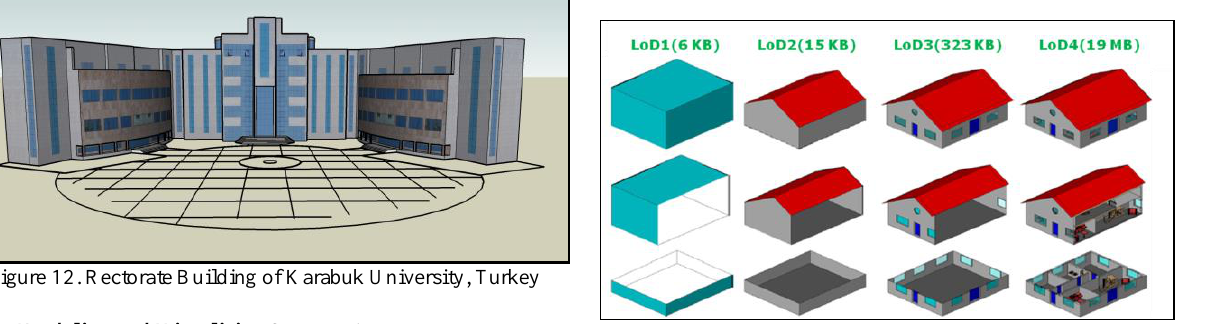
Figure 13. CityGML Data Model